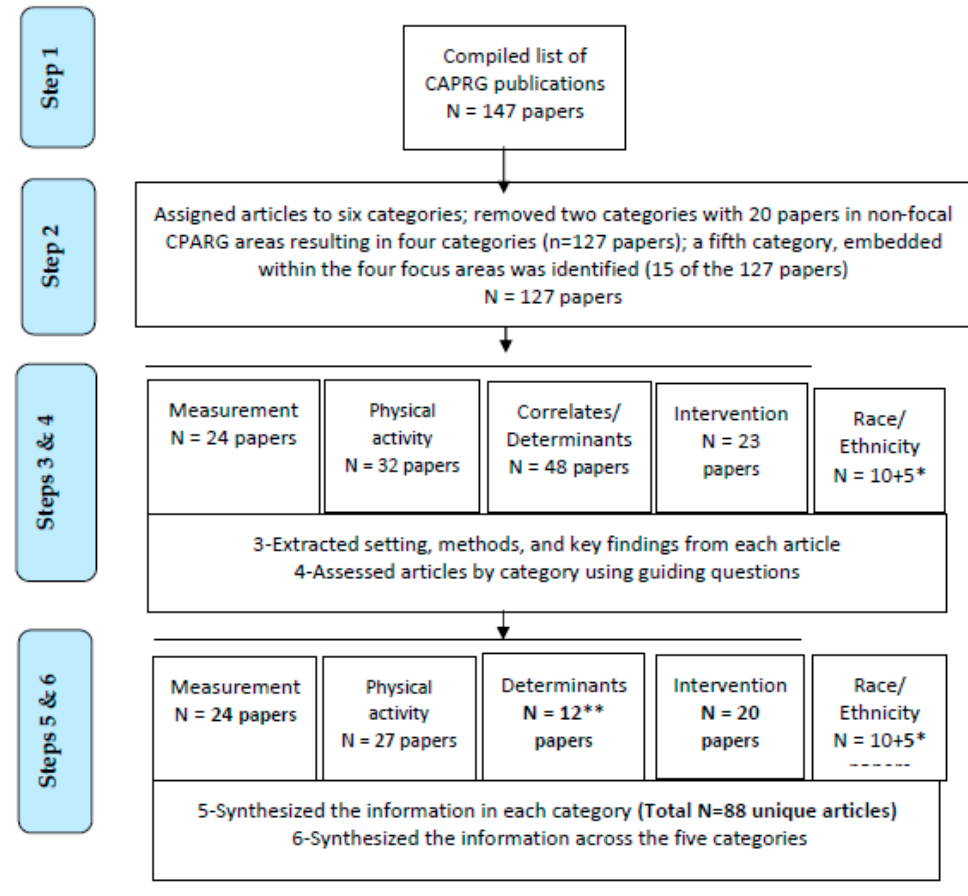
Figure 1. CPARG Publications by Category of Analysis. * 15 papers were drawn from the other four categories (10 duplicate & 5 unique to Race/Ethnicity); ** This subset of papers consists of studies that were longitudinal, included multiple domains of influences, and/or were reports of primary study aims (i.e., focused on determinants versus correlates).